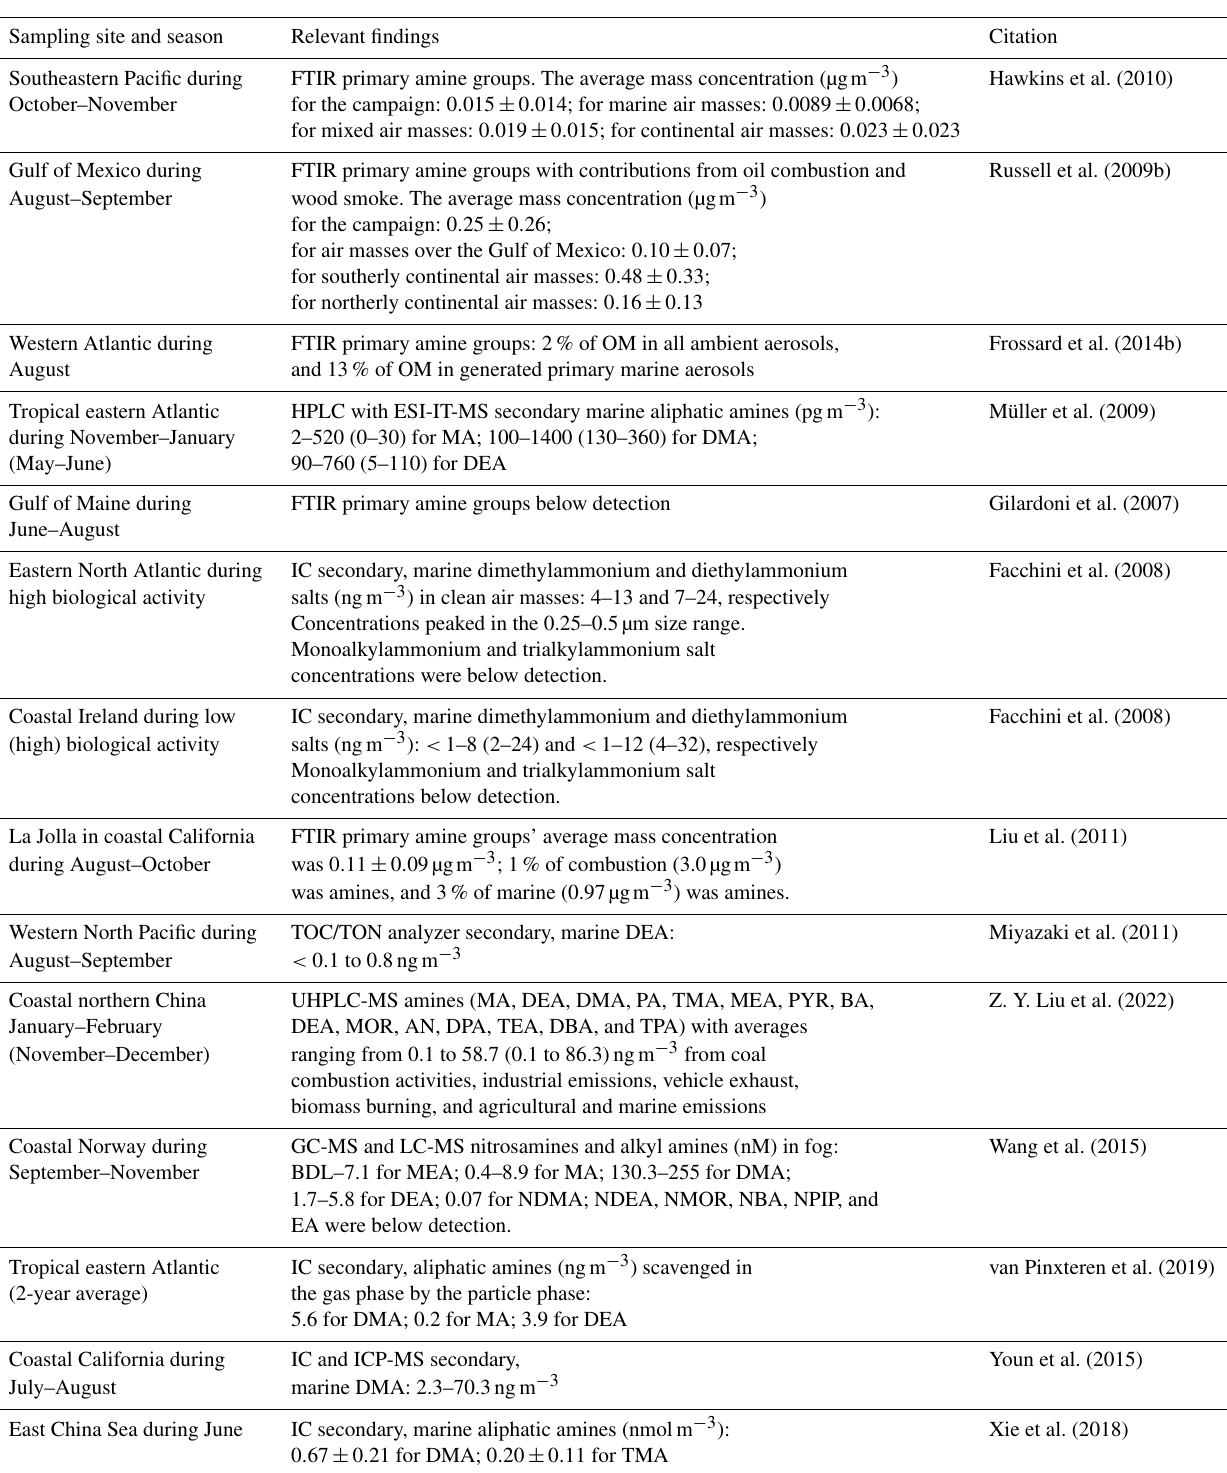
Table 1. Summary of recent measurements of amine concentrations in marine regions. Sampling site and